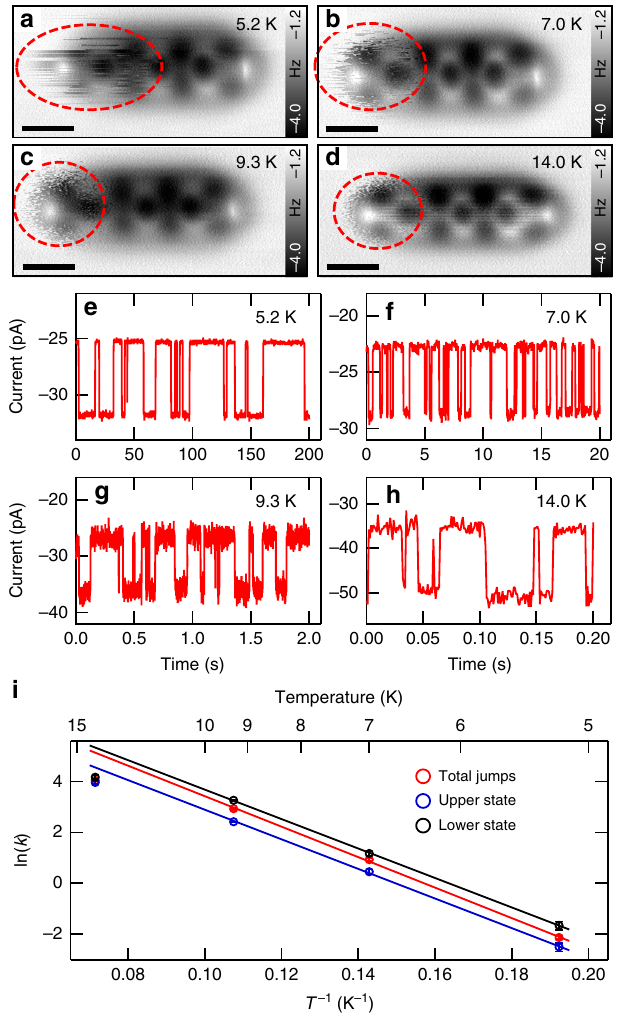
Fig. 2 Dynamics and energy barrier of the observed hopping mechanism. a – d AFM images of type I DATP molecule taken at 5.2 K, 7.0 K, 9.3 K, and 14.0 K. The tip-heights Δ z are a − 90 pm, b − 85 pm, c − 100 pm, d − 90 pm, relative to a STM set point of 100 mV, 10 pA on bare Cu surfaces. e – h Current vs time traces recorded at the fuzzy end at 5.2 K, 7.0 K, 9.3 K, and 14.0 K. Parameters: V bias = 60 mV, tip height Δ z = − 10 pm with respect to the STM tunneling set point of 100 mV, 10 pA on bare Cu(111) surface. i Arrhenius type plot of natural logarithm of the jumping rate ln( k ) vs 1/ T . Displayed are the jumping rates for all jumping events (total jumps, red circles) and the rates for jumps into the upper (blue circles) and into the lower current states (black circles), respectively. An energy barrier ( E α ) of 5.15 ± 0.13 meV and a pre-exponential factor ( A ) of e 9.40±0.22 s − 1 for the total jumps is determined by fi tting the Arrhenius ’ equation ( ln ð k Þ ¼ (cid:2) E α = k B ð Þ 1 = T ð Þ þ ln ð A Þ , where k B is the Boltzmann constant) to the right three points (at 5.2 K, 7.0 K, and 9.3 K). Jumps into lower state: E α = 5.00 ± 0.09 meV, A = e (8.69±0.16) s − 1 . Jumps into upper state: E α = 4.98 ± 0.04 meV, A = e (9.46±0.08) s − 1 . Please note, the data point at 14.0 K has not been taken into account since the observed jumping rate for this vertical error bars in i are derived from the standard deviation of k (see Supplementary Fig. 3). Scale bar: 0.5